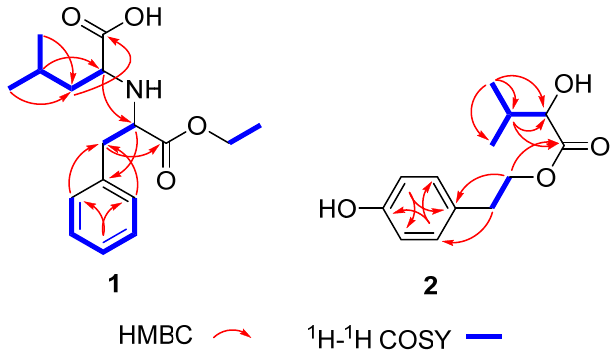
Figure 2. Key 2D NMR correlations of compounds 1 and 2 .